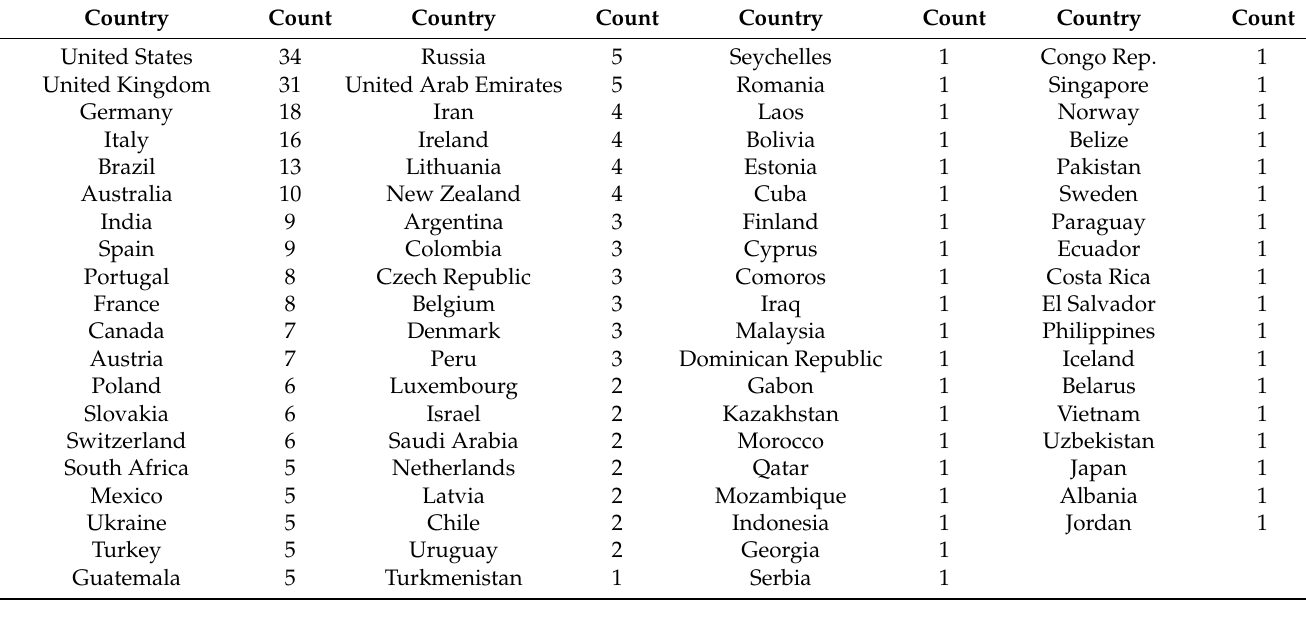
Table 2. Countries of professional activity in the last 12 months.